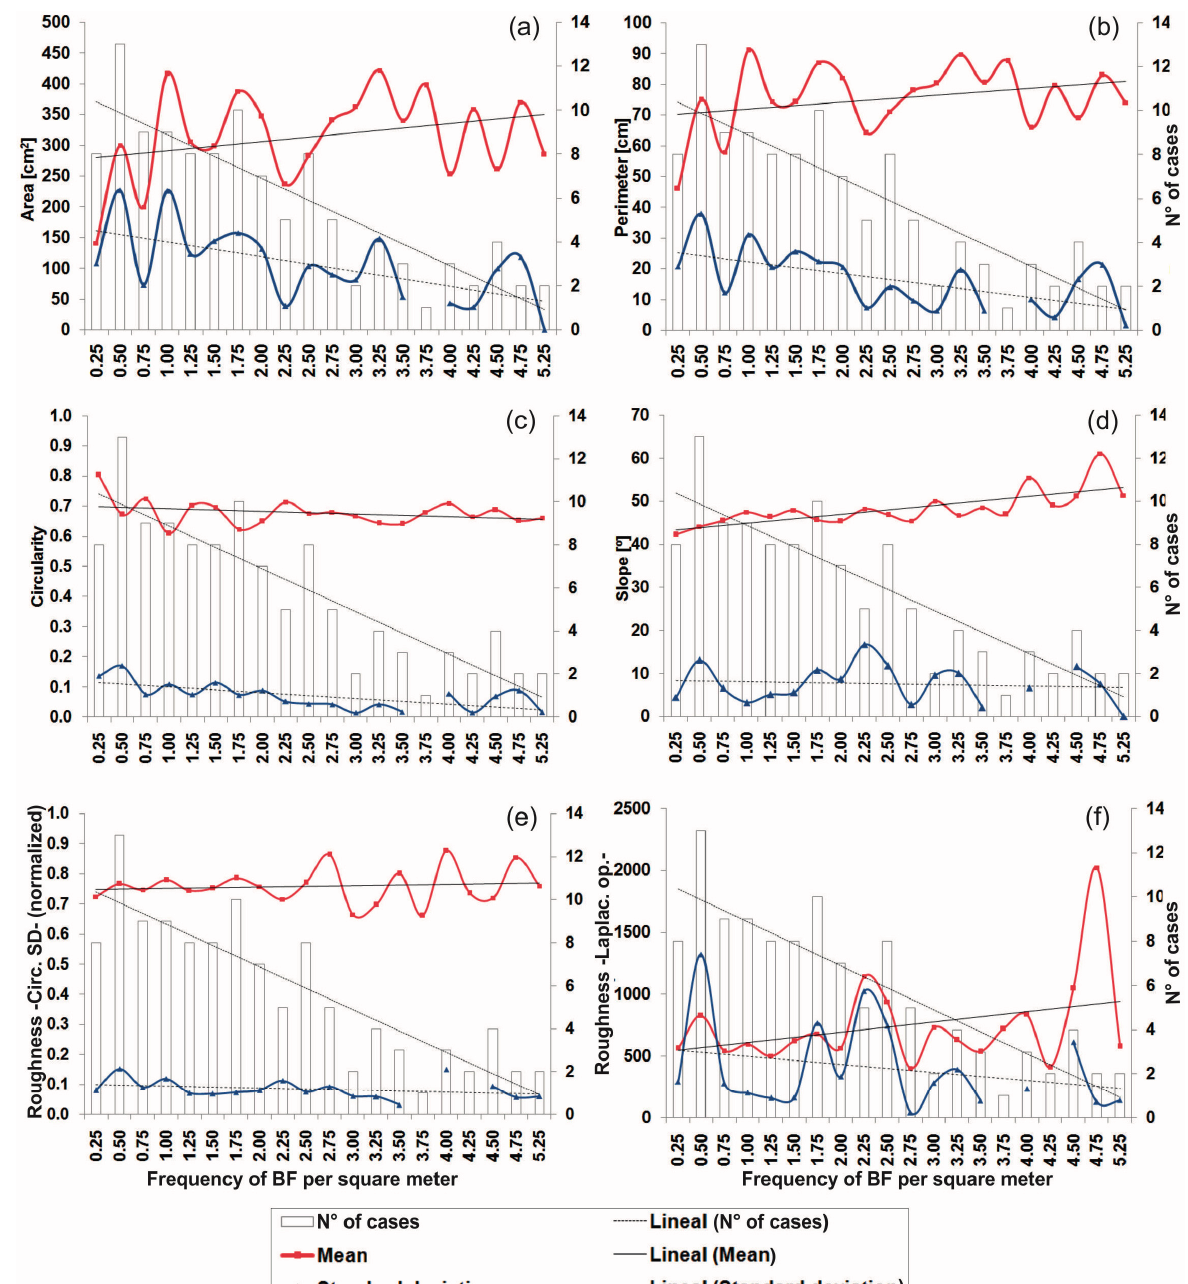
Figure 8. Trend plots of several variables of bioerosion features and surface topography against the frequency of occurrence of bioerosion features. ( a ) Area; ( b ) Perimeter; ( c ) Circularity; ( d ) Slope angle; ( e ) Surface roughness based on circular standard deviation; ( f ) Surface roughness based on Laplacian